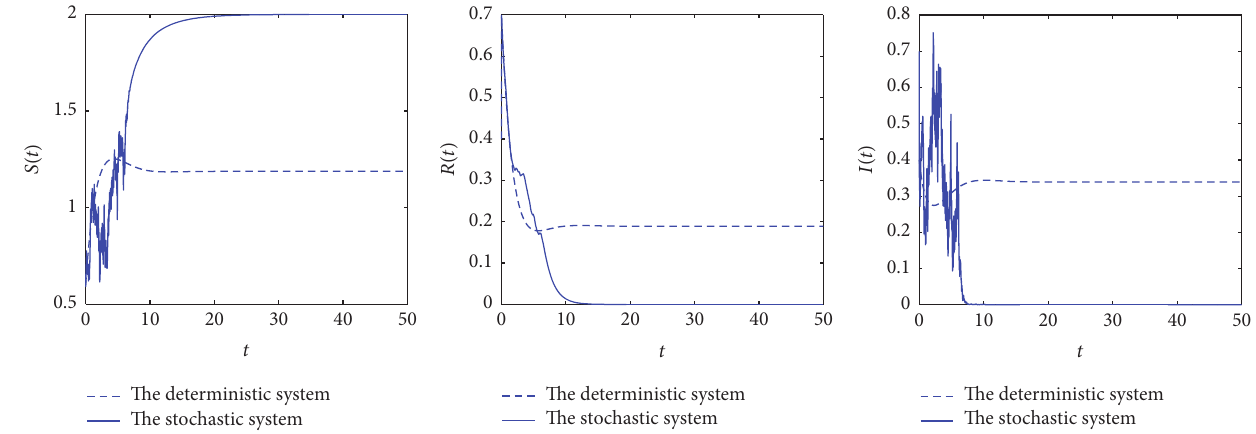
Figure 2: Simulations of the path 𝑆(𝑡) , 𝐼(𝑡) , 𝑅(𝑡) for the corresponding deterministic system (2) and stochastic system (4) with initial value (𝑆(0),𝐼(0), 𝑅(0)) = (0.6, 0.4, 0.5) , 𝜎 = 0.7